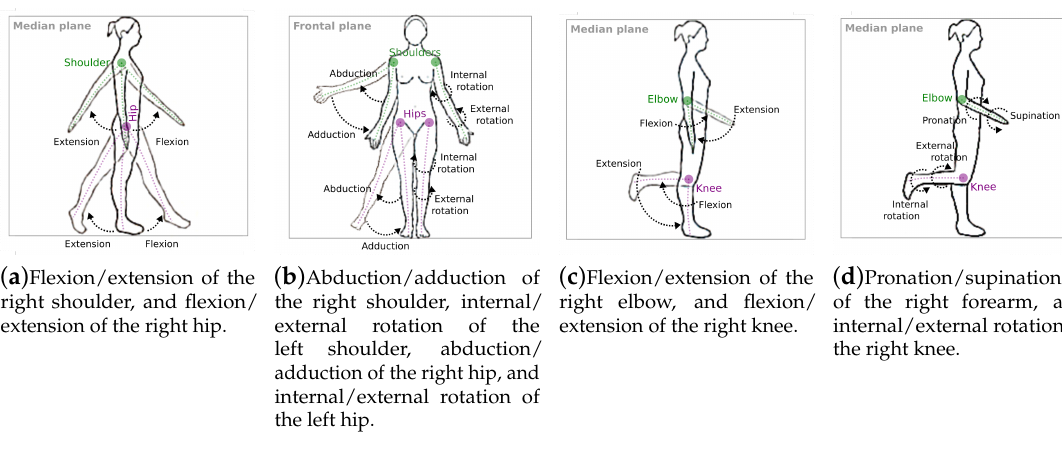
Figure 3. Degrees of freedom of upper and lower limbs considered in this study: 3 for shoulder joint ( a , b ), 3 for hip joint ( a , b ), 2 for elbow joint ( c , d ), and 2 for knee joint ( c , d